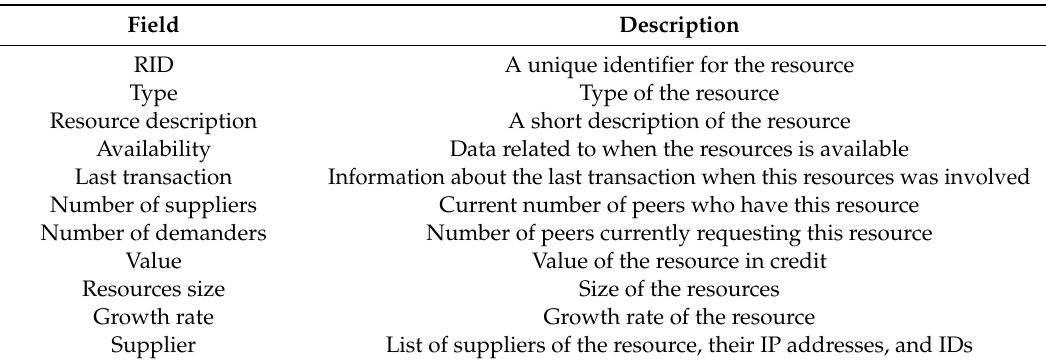
Figure 3. System architecture. Table 1. Main fields in the resources list.